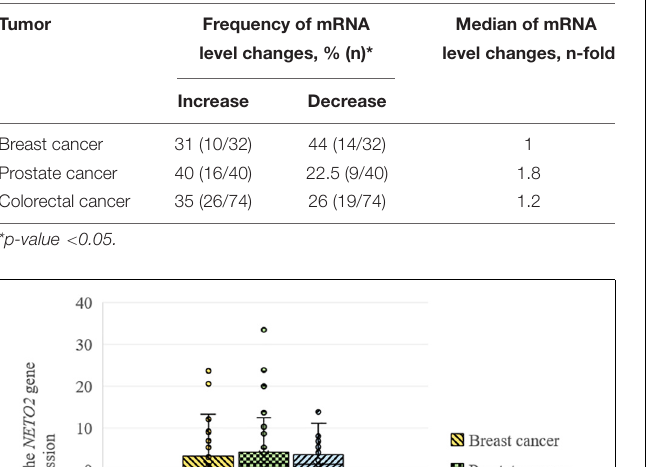
expression. The highest correlation coefficients were observed between NETO2 expression and pathological stage for breast cancer ( r s = 0.15) and prostate cancer ( r s = 0.25), tumor differentiation for prostate cancer ( r s = − 0.16), and BRAF mutation status ( r s = 0.18) for colorectal cancer. Correlation coefficients of less than 0.1 were observed between the NETO2 mRNA level and other investigated clinicopathological characteristics.